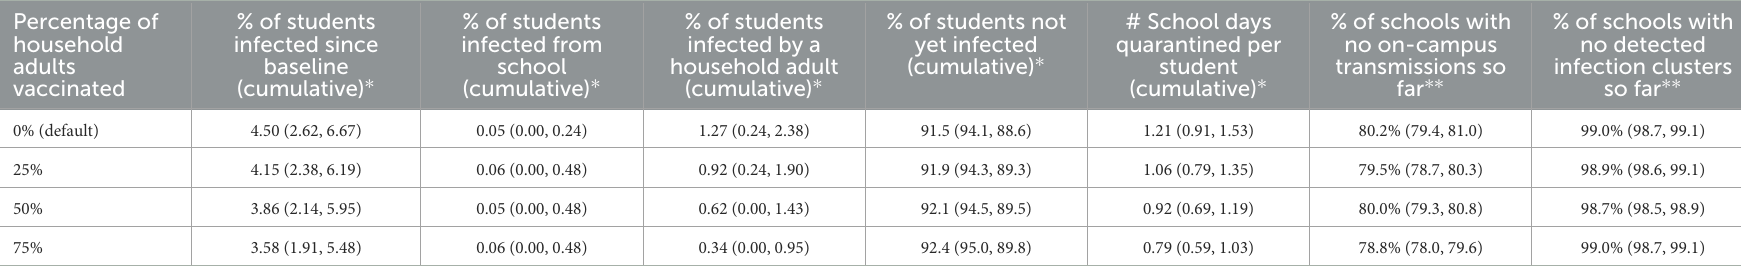
TABLE 4 Mean-average outcomes after 2 months of in-person instruction, by adult vaccination rate.